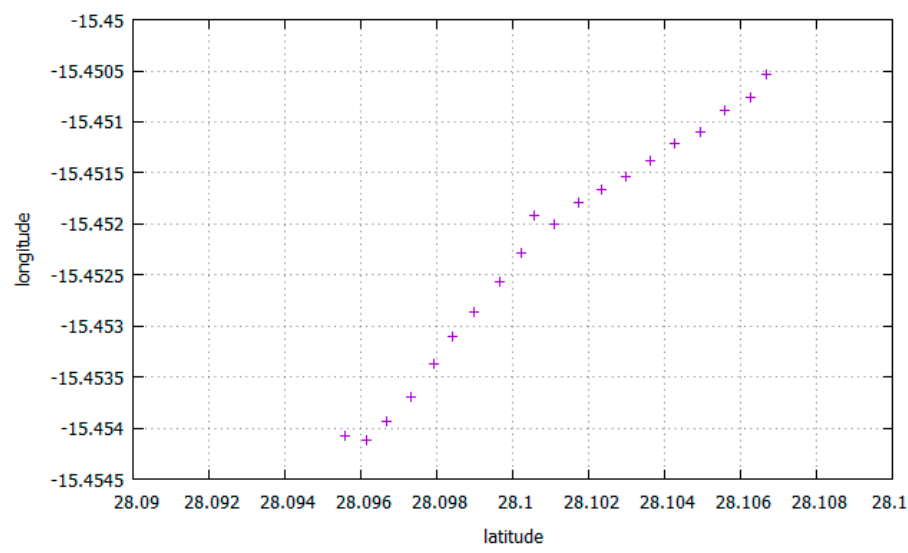
Figure 25. Average location values that are sent to the MAP every minute.